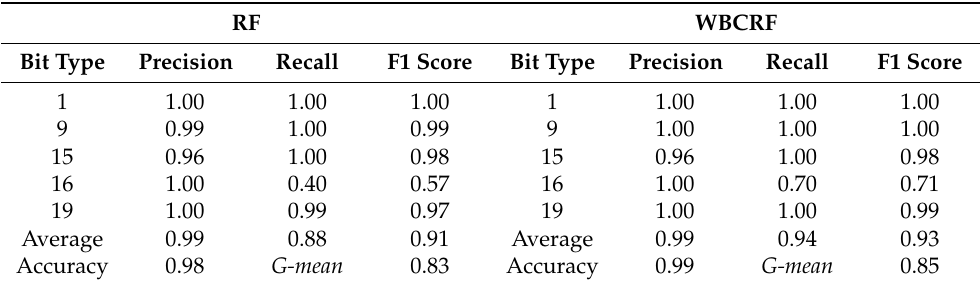
Figure 13. MCC and G-mean scores of machine learning models considered in this study for the first experimental scenario. Table 7. The screening of 17.5” bits through RF and WBCRF models.